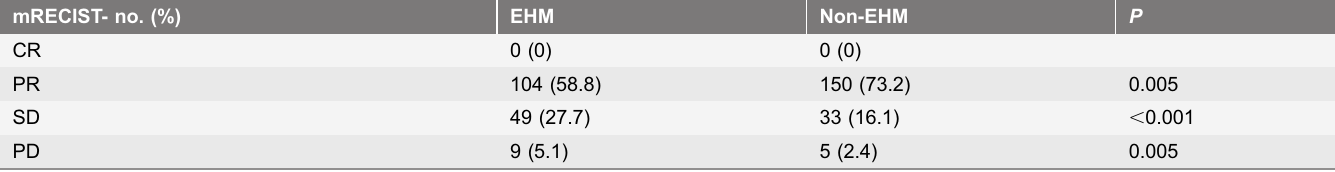
Table 2. Treatment responses after initial TACE for patients with and without extrahepatic metastases. mRECIST- no.